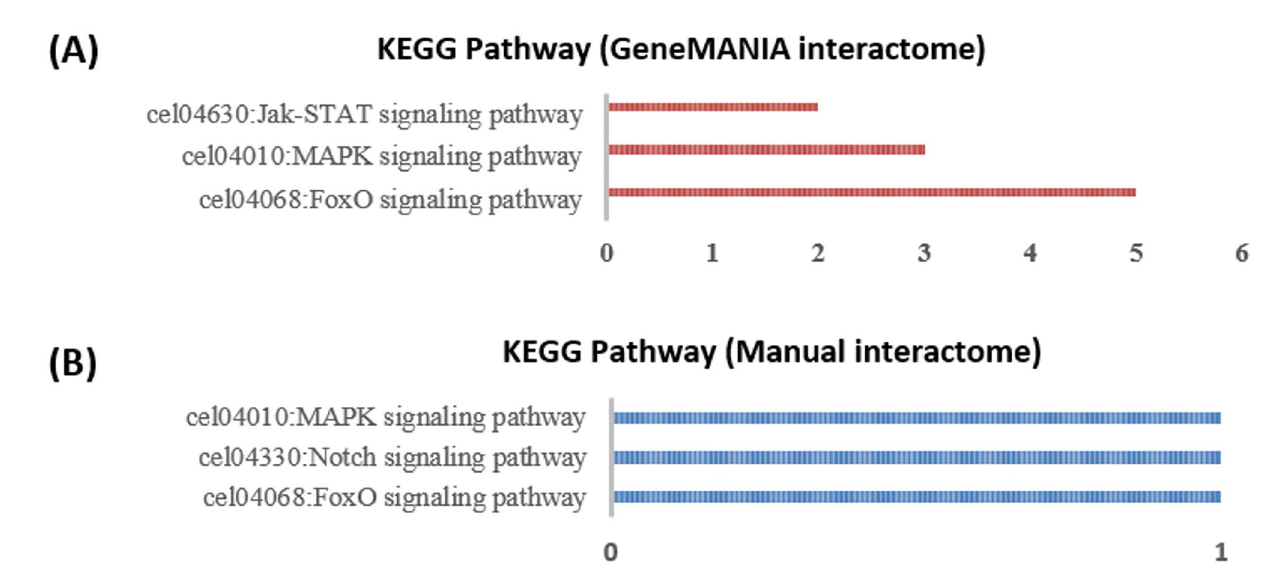
Figure 6. KEGG pathway analysis of protein interactome of C. elegans SIN-3 protein, obtained from ( A ) GeneMANIA database and ( B ) direct evidence method using the NIH LHRI DAVID 6.8 service. The y-axis represents the KEGG Pathways, while the x-axis represents the number of proteins associated with a particular KEGG